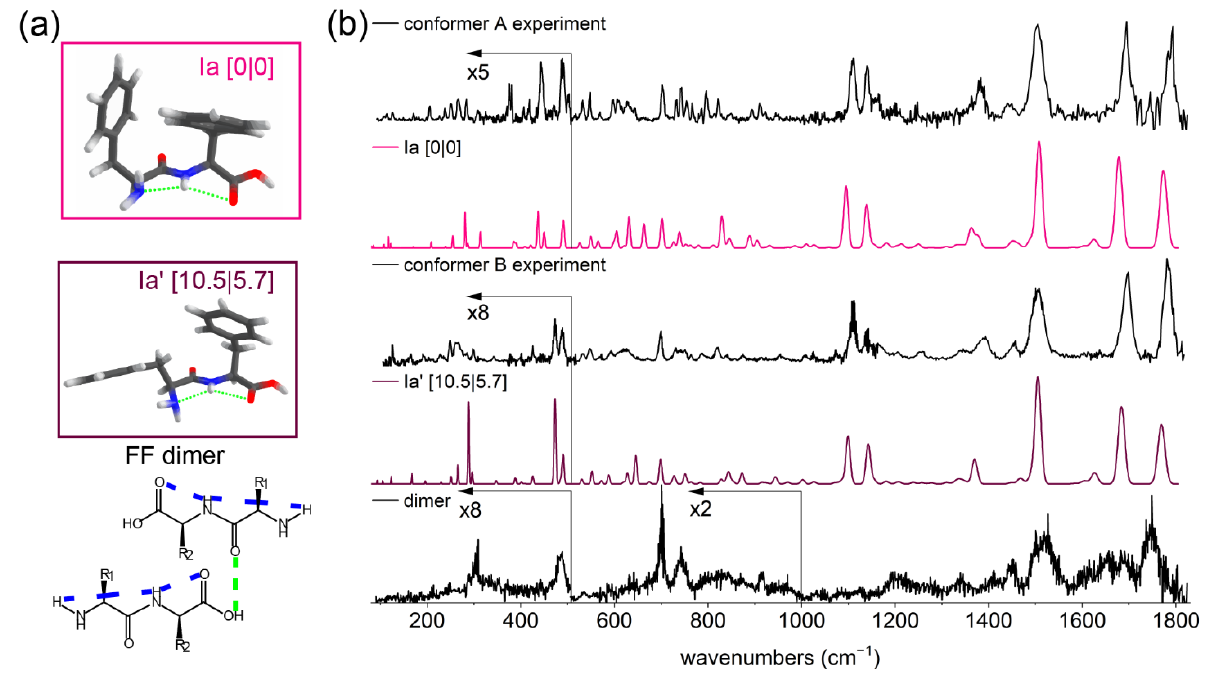
Figure 3. Structural assignment of monomeric FF and IR spectra of the FF monomers and dimer. ( a ) The assigned structures of the FF monomer for conformations A and B with their zero-point energies and Gibbs free energies at 300 K in kJ/mol shown between square brackets. The predicted assigned structure of the FF dimer is shown below with intra- and intermolecular hydrogen bonds in blue and green dashed lines, respectively. Side groups are shown as R 1 and R 2 . ( b ) The experimental spectra of conformer A and B of the monomer (black) and the calculated IR spectra of the corre- sponding assigned structures for the monomers (pink and purple) and the experimental IR spec- trum of the FF dimer (black, bottom). Calculated spectra are scaled by 0.976. The region below 520 and 1000 cm − 1 was multiplied for clarity, as indicated in the figure.